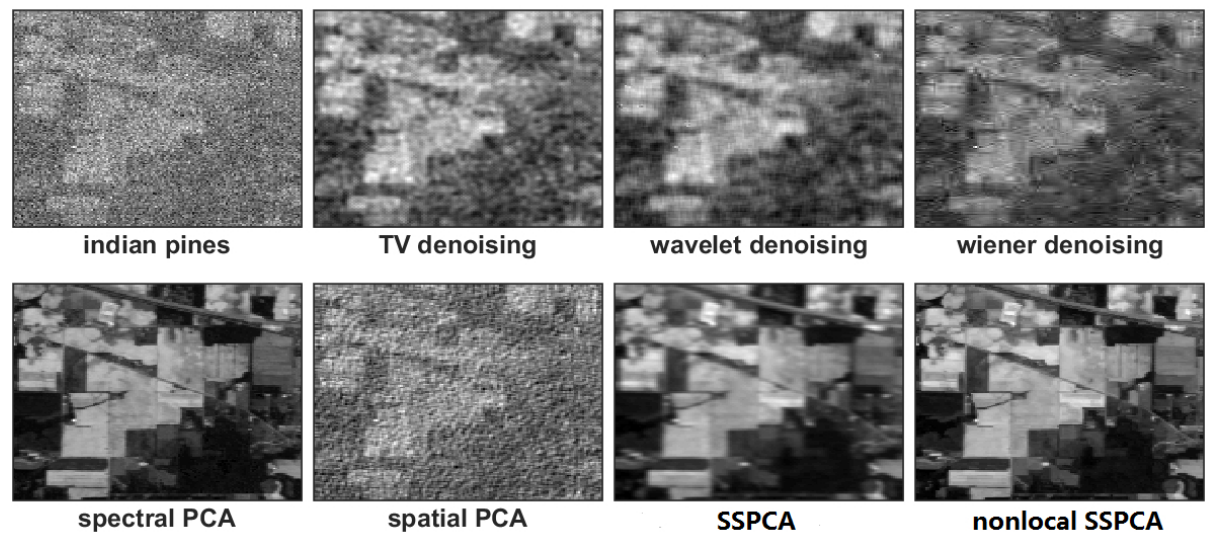
Figure 6. Denoising results achieved by different methods on band 200 of real data. It can be clearly seen that the proposed nonlocal SSPCA method achieved better denosing results than other all methods. Because of containing nonlocal spectral information and spectral information in PCA denoising model, it reduces most random noise efficiently, while also preserving image details, e.g., birght boundary information and point targets very